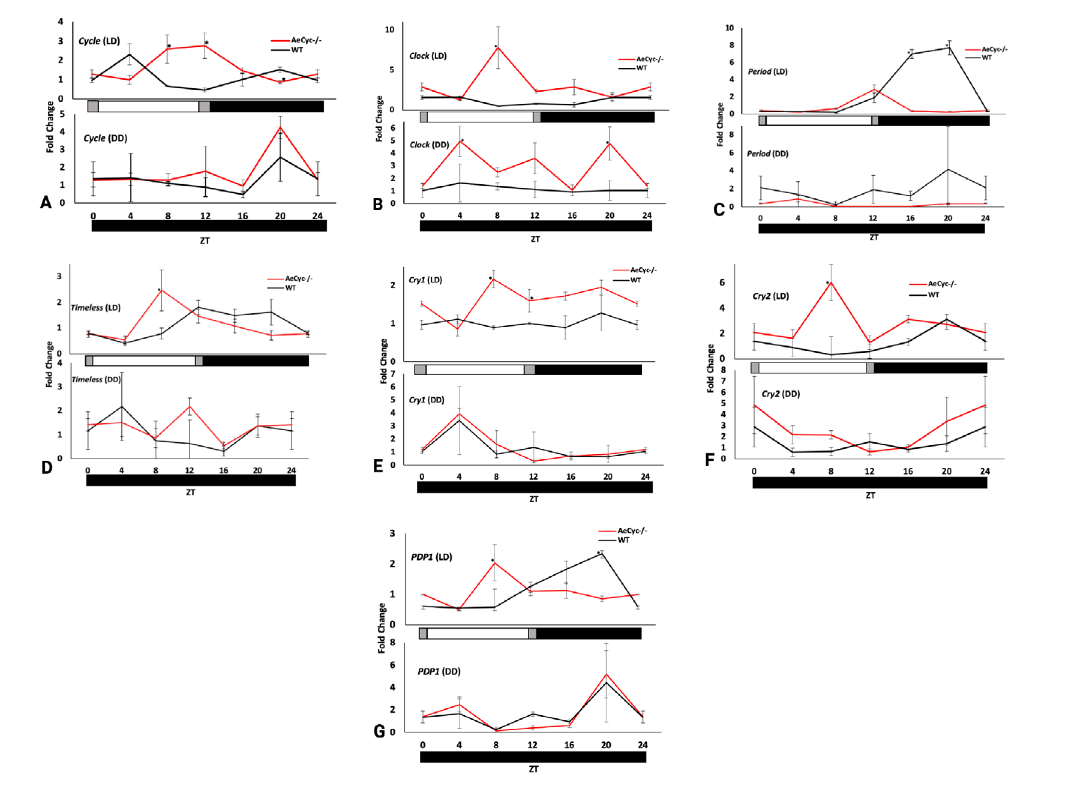
Figure 2. Gene expressions of ( A ) cycle , ( B ) clock , ( C ) per , ( D ) tim , ( E ) cry1 , ( F ) cry2 , ( G ) pdp1 in AeCyc −/− and wildtype mosquitoes at different time points across LD and DD cycles. Relative mRNA expression measured by quantitative real-time PCR. Each timepoint represents the average of three biological replicates (n = 3). Black bars = light off, white bars = bright light, dark gray bars = dim light. ‘*’ indicates statistically significant differences (p ≤ 0.05) in peaks between AeCyc −/− and wildtype at each time